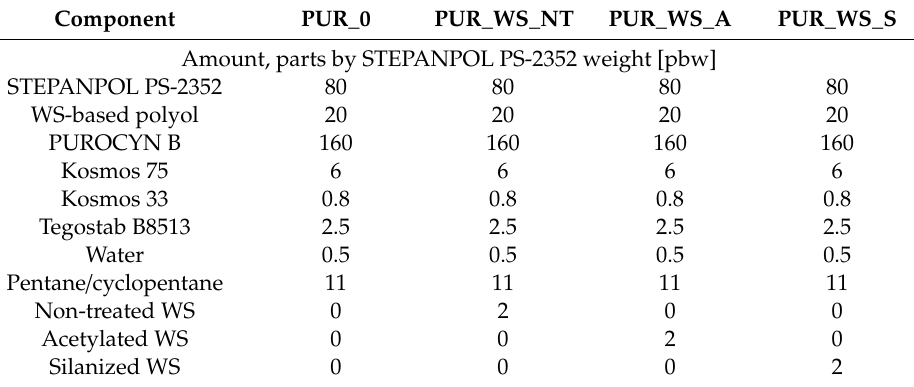
Table 1. The weight ratio of components used for polyurethanes (PUR) foam